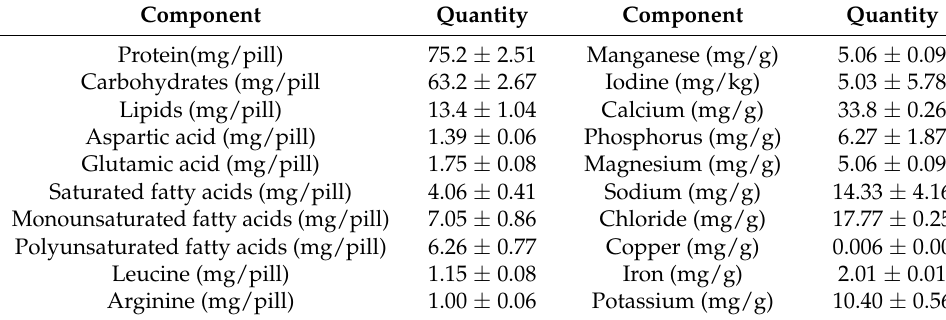
Table 1. Composition of TetraSOD ® from Fitoplacton marino S.L.